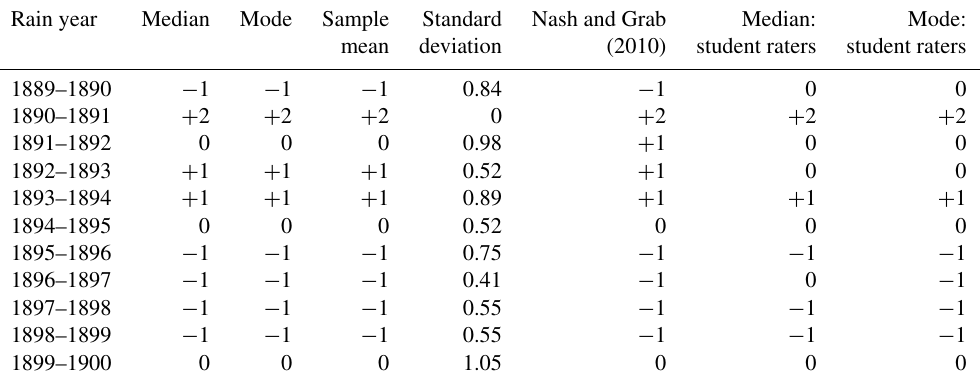
Table 3. Summary statistics of index values applied to the 11 rain years by the six professional raters. Nash and Grab (2010) and the median and mode of the student raters (from Table 1) are provided for comparison.